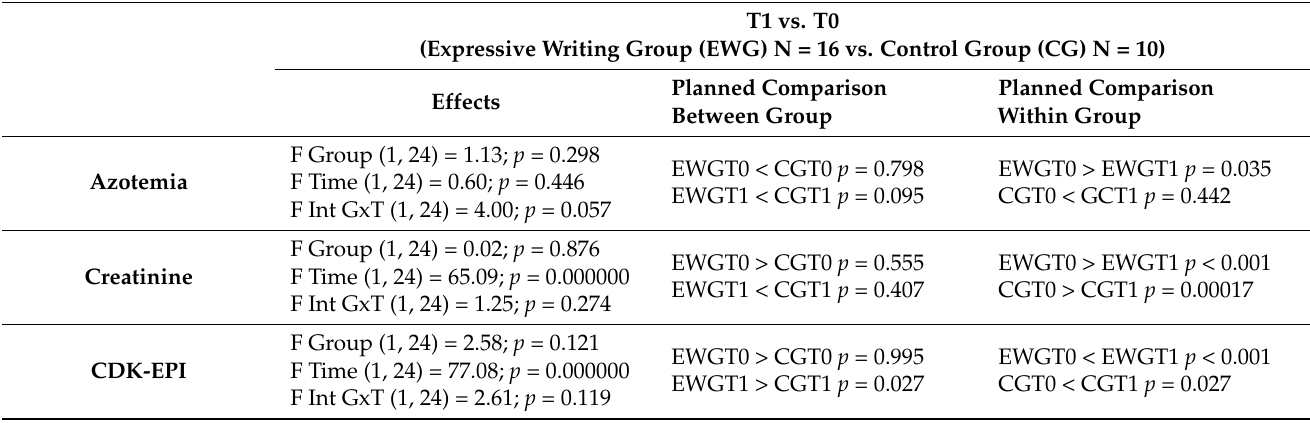
Table 3. Repeated Measure ANOVA Expressive Writing Group vs. Control Group per 3 times (T1 vs. T0 and T2 vs. T1) on significant psychological variables (BDI-II, STAI-Y1, STAI-Y2, TAS-20, IRI, CD-RISC) and on significant biological variables (Azotemia, Creatinine, CDK-EPI). In ( a ) are reported between group and within group planned comparisons related to the two at T1 vs. T0 time; in ( b ) are reported between group and within group planned comparisons related to the two at T2 vs. T1